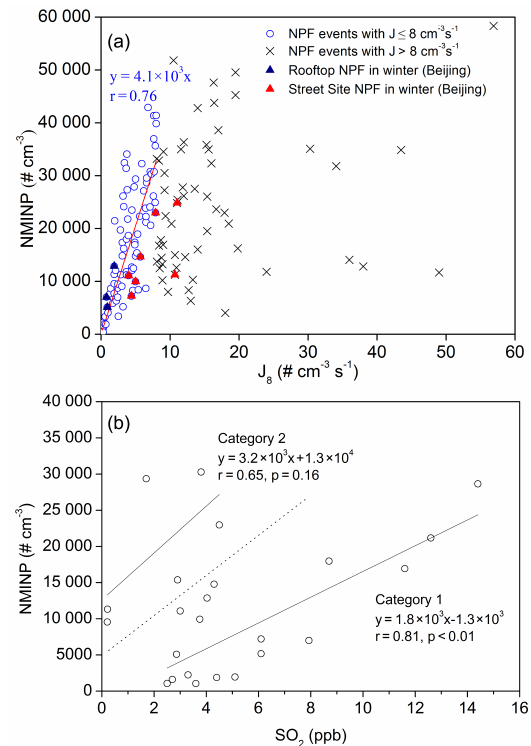
Figure 9. Relationship between NMINP and FR ( J 8 ) in 139 cases of NPF events and between NMINP and SO 2 in some cases ( a NMINP vs. FR ( J 8 ) ; b NMINP vs. SO 2 ; the dash line in (b) is arbitrarily drawn; the averaged mixing ratio of SO 2 during each NPF event was used, and missing SO 2 data are due either to malfunction of instruments or to further QA/QC being